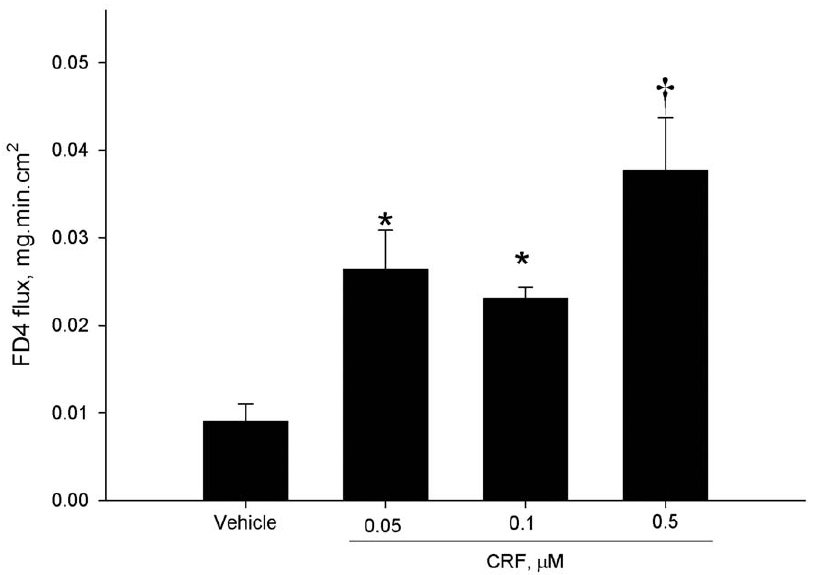
Figure 1. CRF induces elevations in FD4 flux in porcine ileum. Porcine ileum was placed on Ussing Chambers and treated with CRF at increasing concentrations (0.05, 0.1, and 0.5 m M) and the rate of FD4 flux was measured over a 180-minute period. CRF at all concentrations induced elevations in FD4 flux (p , 0.01) with the highest FD4 flux rates observed with 0.5 m M CRF. Data for each experimental treatment are expressed as means 6 SE for n=6 2 8 pigs. Symbols (*, { ) differ from other treatments by p , 0.05;